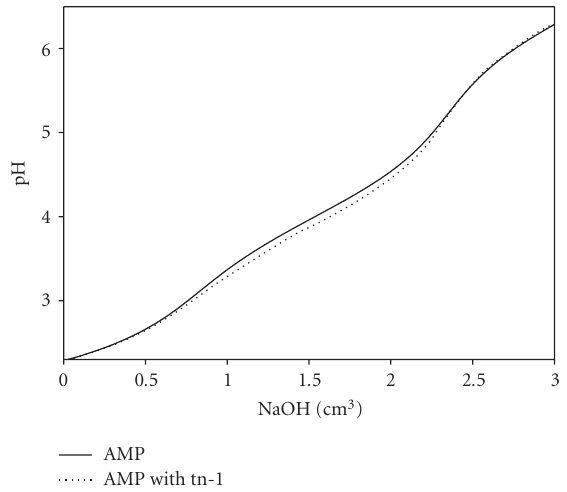
Figure 2: Titration curves of the AMP and AMP/tn-1 systems; C AMP = 0.01M, C = 0.01 M C = 0.1915 tn-1 NaOH